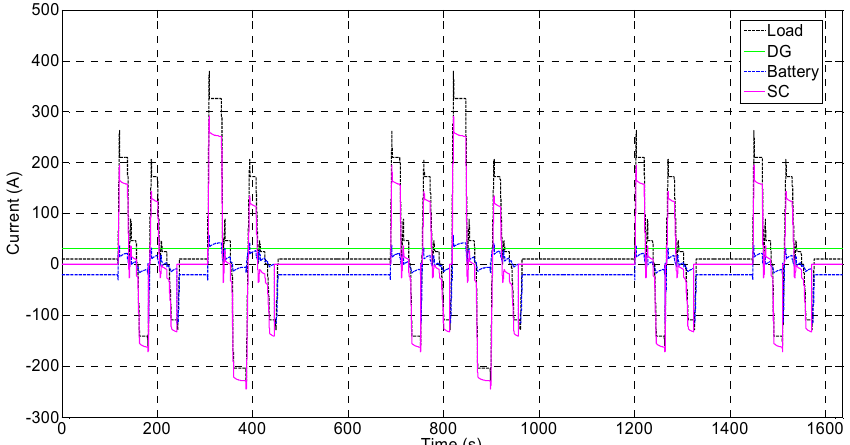
Figure 15. Output currents of the three devices under intermittent work.